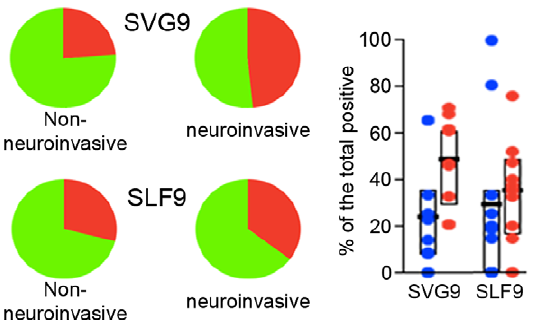
Figure 7. Cytolytic responses of CD8 + cells stimulated with the SGV9 immunodominant WNV peptide are augmented in subject with neuroinvasive involvement. PBMC from donors with or without neuroinvasive disease were stimulated with the immuno- dominant SVG9 or subdominant SLF9 peptide WNV epitopes and functional responses were evaluated as described. Percentages of CD8 + T cells expressing the cytotoxicity surrogate marker CD107a were added for each of the 32 combinations shown in Figure 5 using SPICE software. Pies represent the distribution of CD107a positive (red) and negative (green) for the two epitopes. Bars represent the interquartile range (25% –75%) of the CD107a response for the two cohorts. Wilcoxon signed-rank test was performed for the two antigens.